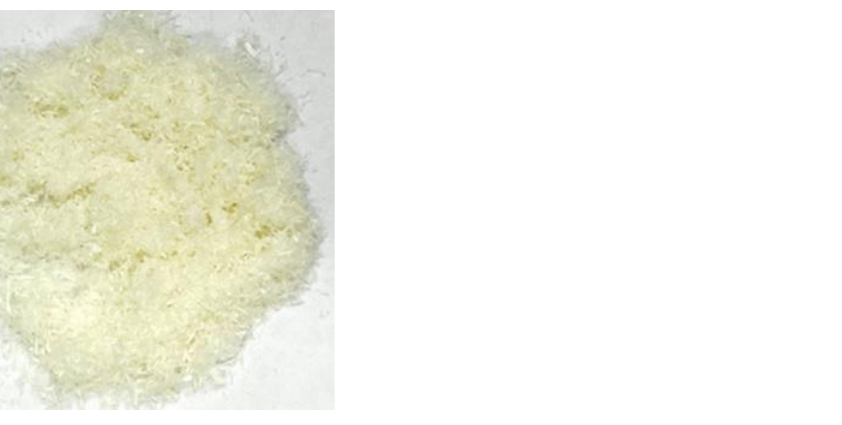
Figure 1. Cellulosic product obtained by peroxide delignification of spruce wood in the CH 3 COOH‒H 2 O 2 ‒H 2 O medium over the sulfuric acid catalyst.